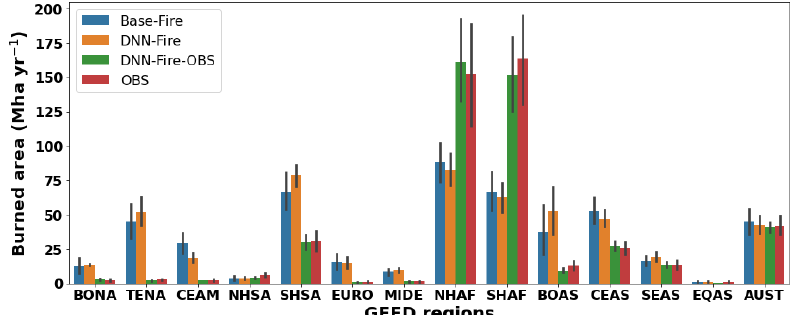
Figure 3. A comparison of wildfire burned area between estimates from the ELMv1 process-based model (BASE-Fire), deep neural network wildfire model (DNN-Fire), deep neural network wildfire model fine-tuned with observed burned area (DNN-Fire-OBS), and observations over 14 GFED fire